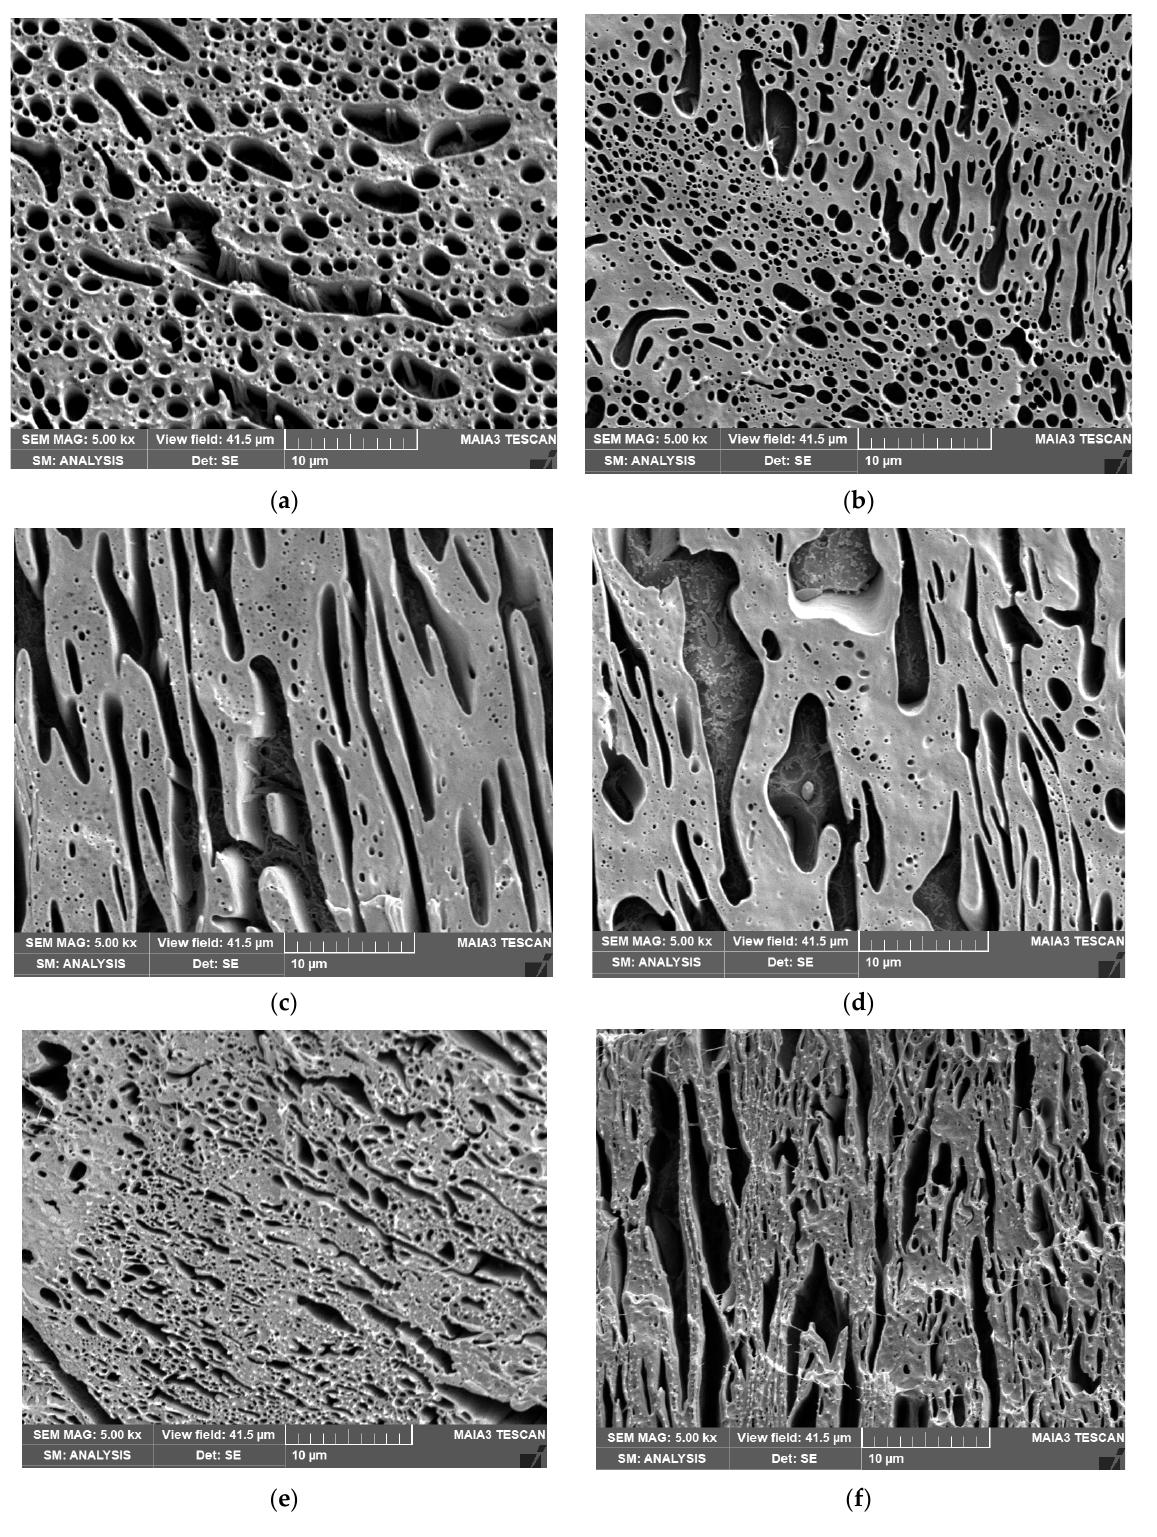
Figure 4. SEM images of 40/60 systems: ( a ) neat blend with DMF treated PLA; ( b ) DMF-treated PCL; NC with ( c ) PLA/CNC masterbatch, ( d ) PCL/CNC masterbatch, ( e ) PLA/CNCd masterbatch, and ( f ) PCL/CNCd masterbatch; the dark area represents the NaOH-removed PLA phase. A structure of the unetched sample ( d ) is shown in Figure S1b.